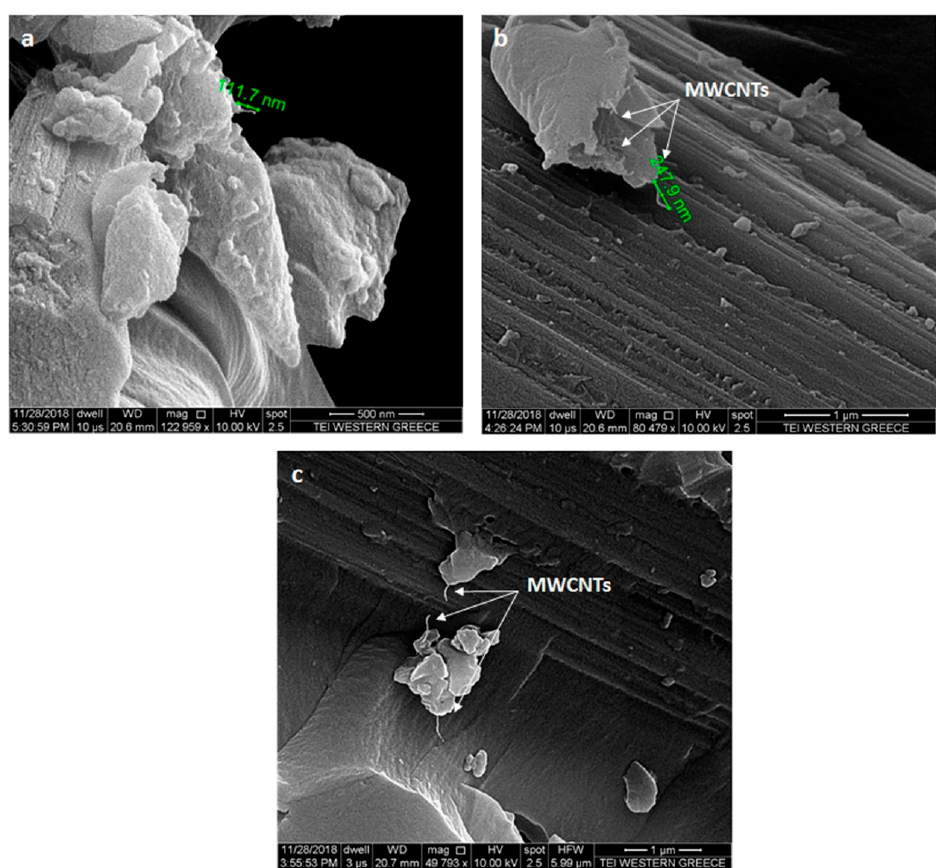
Figure 9. Scanning electron microscope (SEM) micrographs of impacted specimens with 1.5 wt.% MWCNTs at different magnifications at three impact energy levels ( a ) 8 J, ( b ) 15 J and ( c ) 30 J.